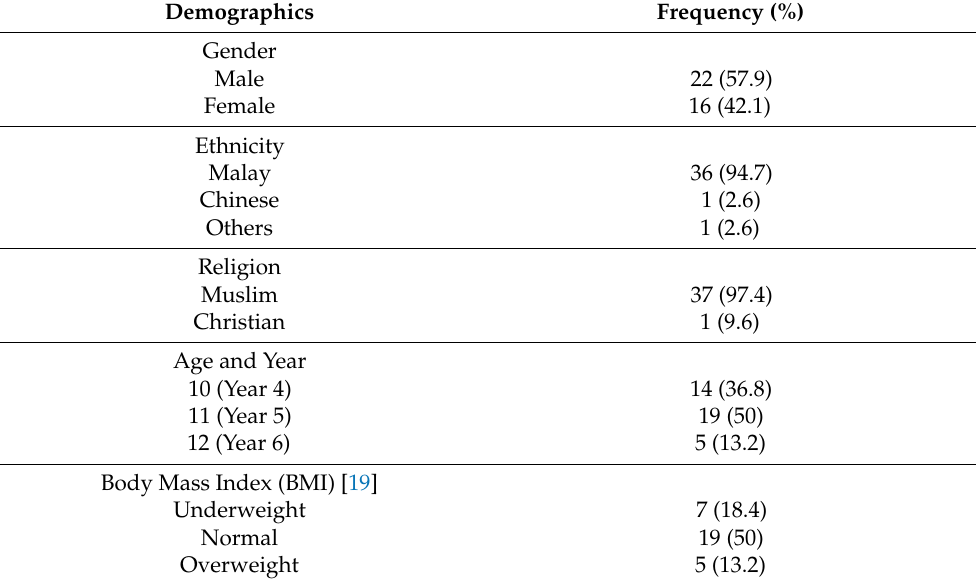
Table 1. Demographic